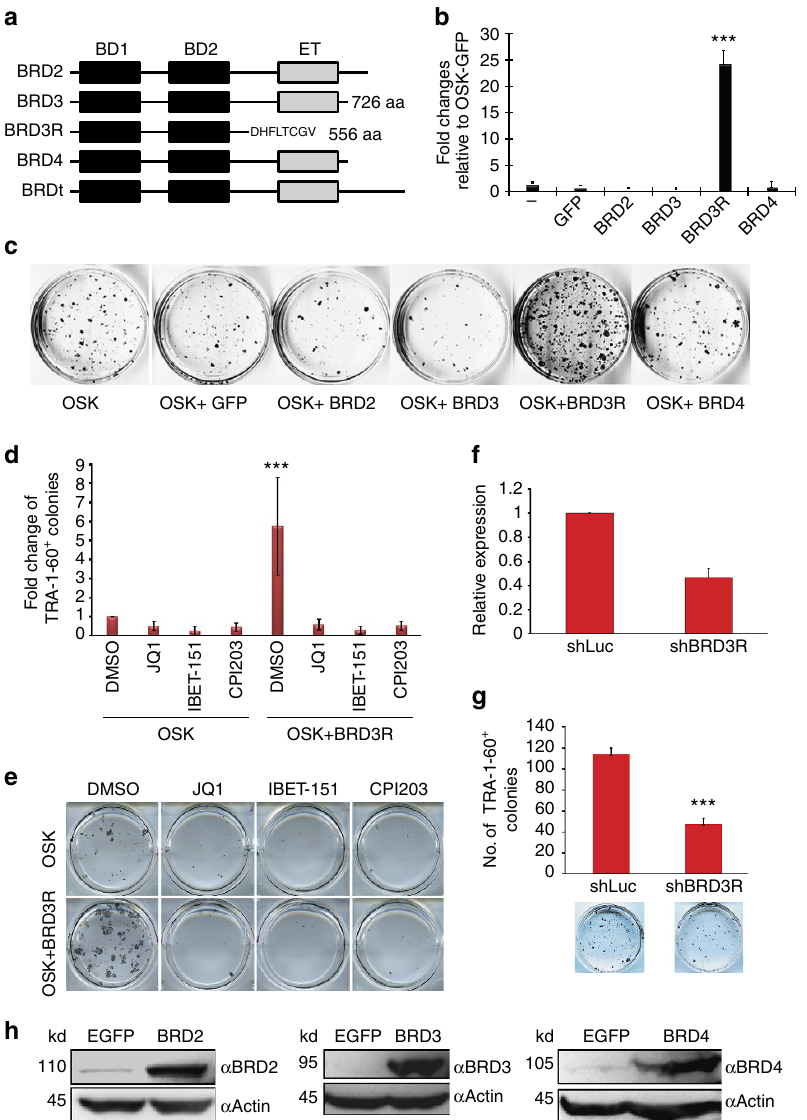
Figure 3 | Other human BET members do not exhibit reprogramming activities, but BET inhibition impairs human reprogramming. ( a ) Domain structure of human BET family members (not to scale). Black box, bromodomain; grey box, ET domain; the single-letter sequence at the C-terminus of BRD3R is the unique tail of BRD3R as a result of alternative splicing. ( b ) Only BRD3R demonstrates reprogramming promoting activity. Shown are fold change in numbers of TRA-1-60 þ colonies for reprogramming with different human BETmembers when used with 3F in reprogramming of human BJ cells, as compared with OSK-GFP control. BRDT was not tested due to its restricted expression. ( c ) Representative images of TRA-1-60 staining for the reprogramming dishes of experiments in b . ( d ) BET inhibition impairs human reprogramming. Presented are fold changes of TRA-1-60 þ colonies for reprogramming treated with various BET inhibitors for 5-7 days with JQ1 (500nM), I-BET-151 (10 m M), CPI-203 (1 m M) and DMSO as control. ( e ) Representative reprogramming dishes from d stained for TRA-1-60. ( f ) Quantitative RT–PCR showing significant knockdown of BRD3R mRNA with a BRD3R-specific shRNA. ( g ) BRD3R knockdown impairs human reprogramming. Presented are numbers of TRA-1-60 þ colonies. Images beneath each bar are representative reprogramming dishes stained for TRA-1-60. ( h ) Viruses efficiently express BETproteins in BJ reprogramming cells as shown by western analyses. Data are presented as mean ± s.d. ( n ¼ 3). * P o 0.05; *** P o 0.001; t